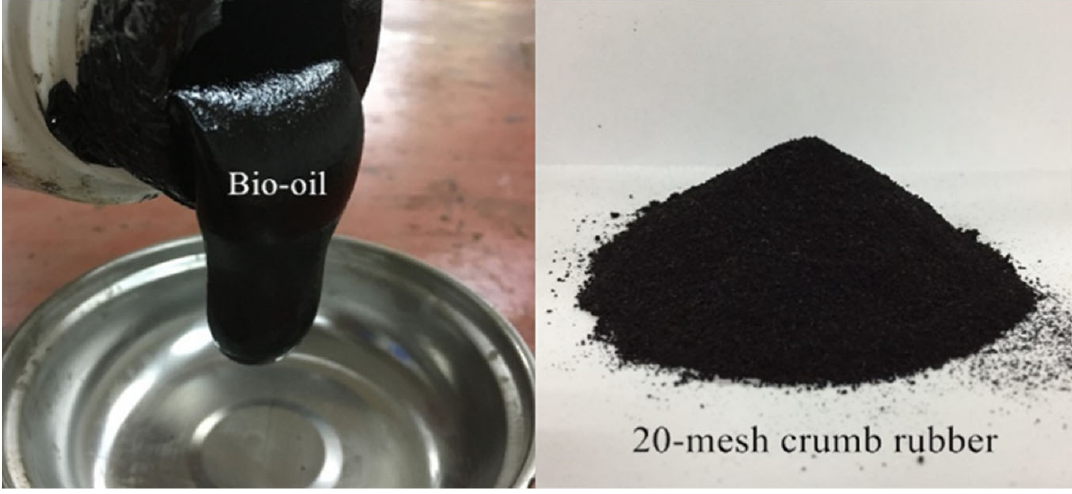
Figure 4: Used bio-oil and crumb